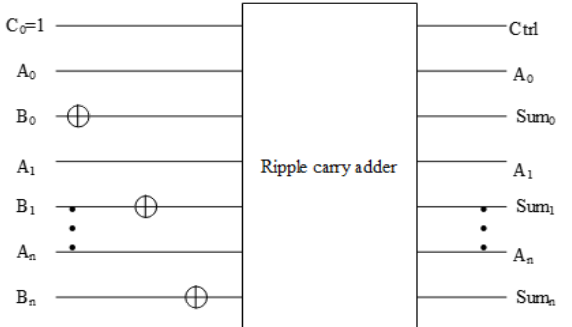
Figure 7. Quantum Subtractor for n qubits adopted from [10] with T-count = 4 n , T-depth = 2 n and ancillae = n